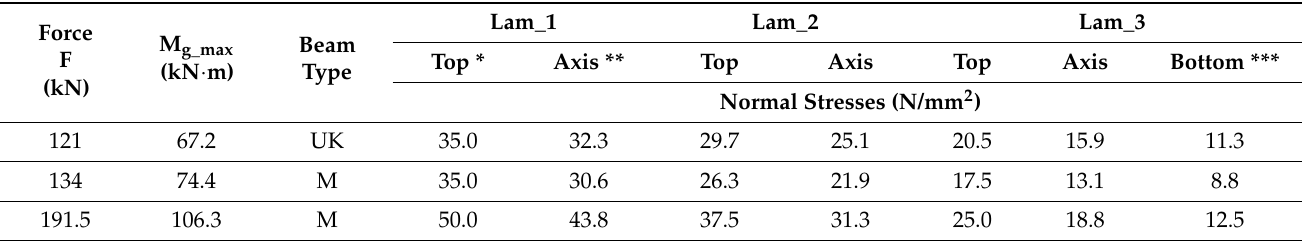
Table 5. The values of normal stresses acting on individual lamellas.